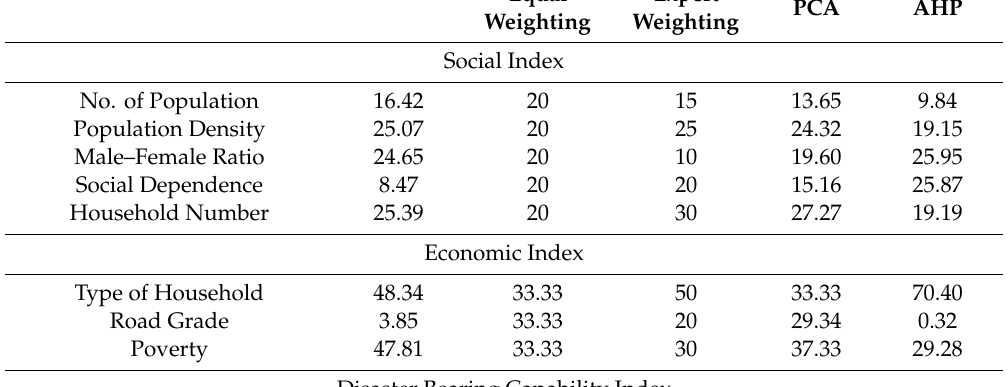
Table 3. Weights of various socio-economic indicators computed by MSF and other weight methods. Explicit Socio-Economic Indicators MSF